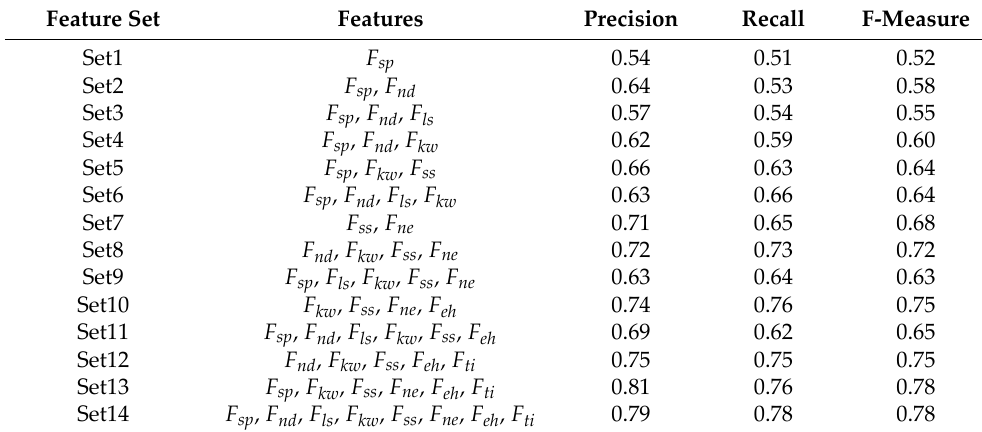
Table 7. Evaluation measure for 25% compression rate.